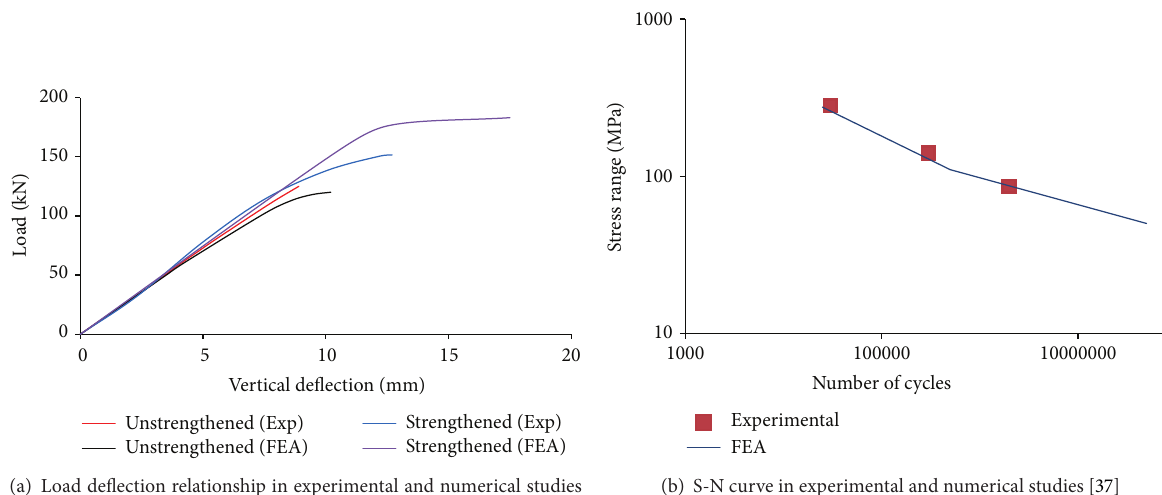
Figure 5: Comparison of experimental and simulation outputs of steel